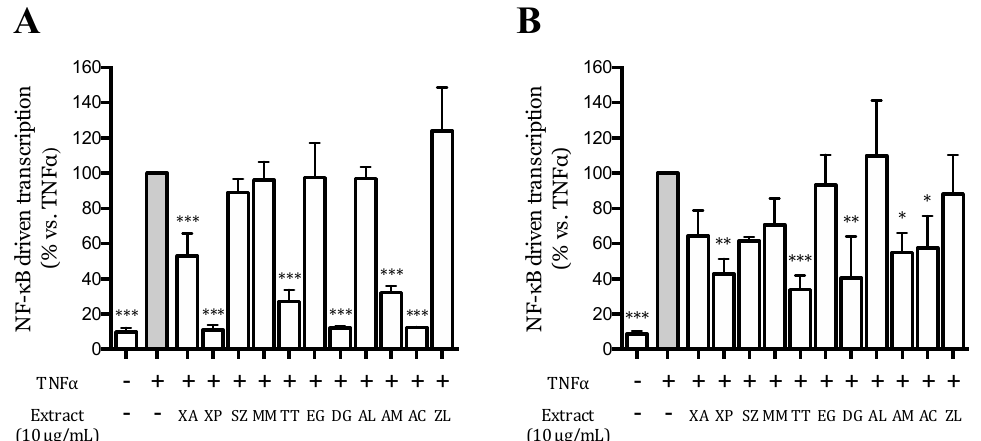
Figure 2. Effect of the extracts (10 μ g/mL) on the NF- κ B-driven transcription in human gastric adenocarcinoma (AGS) ( A ) and gastric epithelial (GES-1) ( B ) cells. Data are expressed as percentage versus the stimulated control, which is arbitrarily assigned the value 100% (grey bar). * p < 0.05; ** p < 0.01; *** p < 0.001.